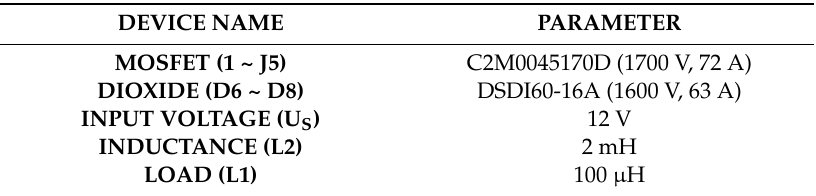
Table 1. Main device parameters of the circuit.